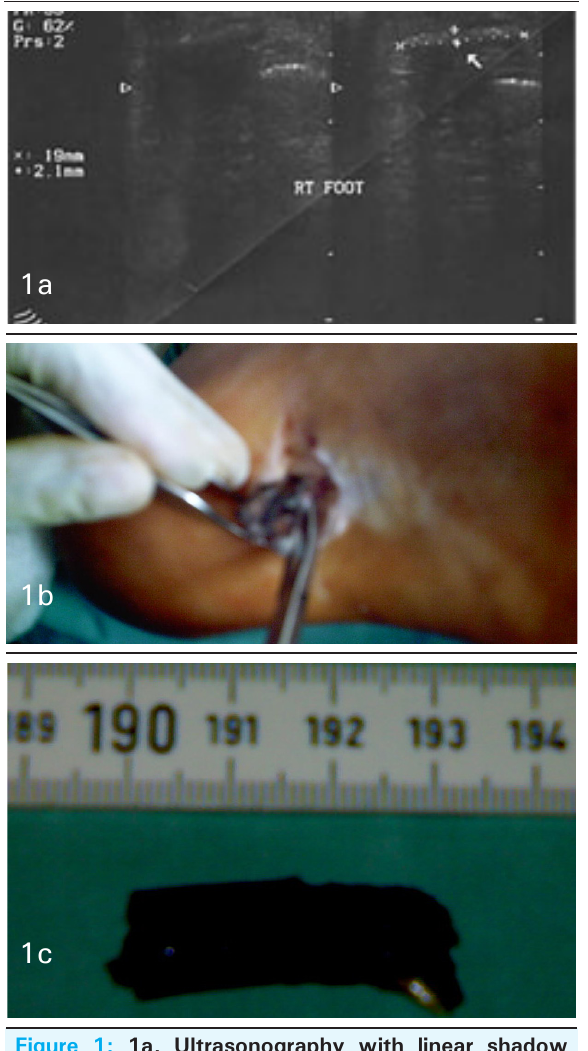
figure 1: 1a. Ultrasonography with linear shadow with distal acoustic shadow figure 1b, 1c. Wooden splinter (arrow head) removed from sole